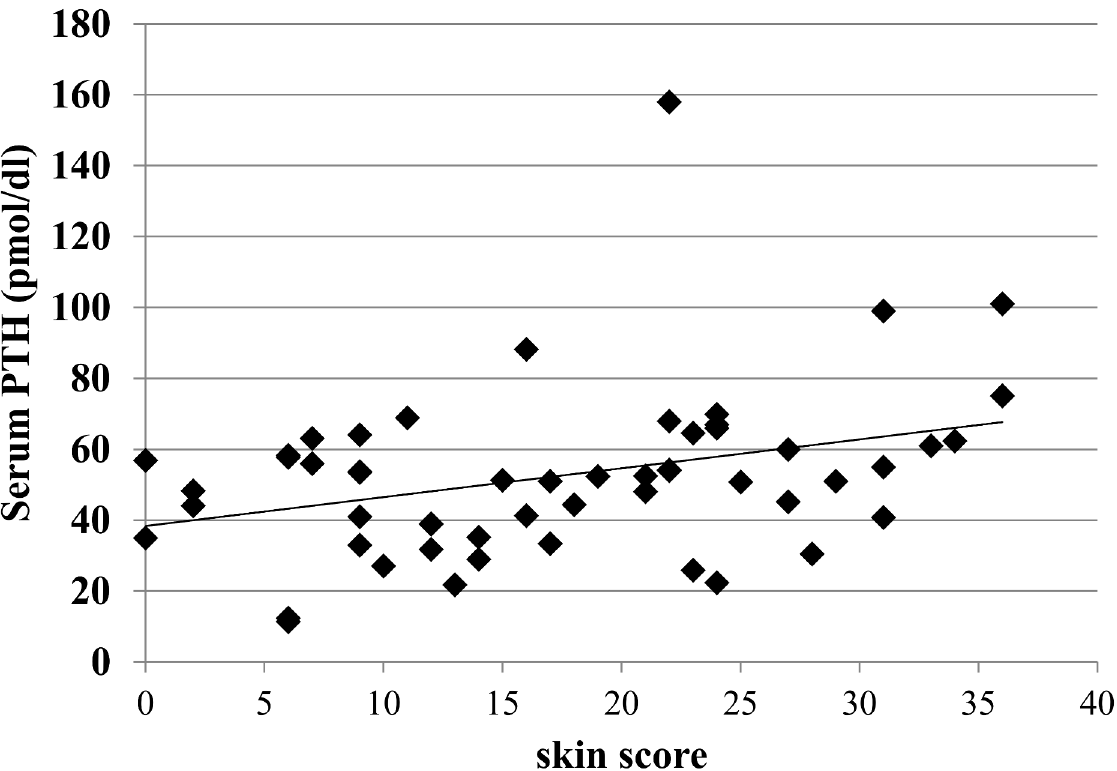
Fig 4. Relationship between the degree of skin fibrosis assessed by modified Rodnan skin score and 25OHD levels in SSc patients. A significant inverse relationship between the degree of skin fibrosis and circulating levels of 25OHD (r = -0,7, p < 0,05).